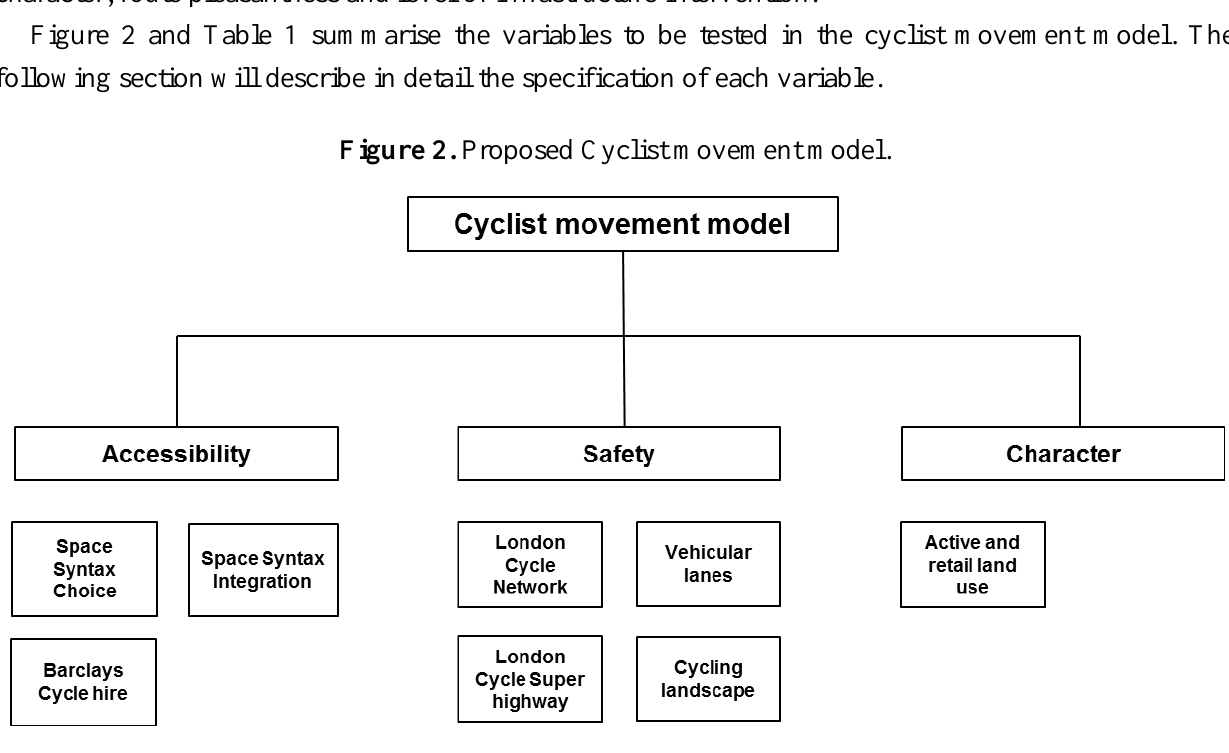
Table 1. Cyclist movement model